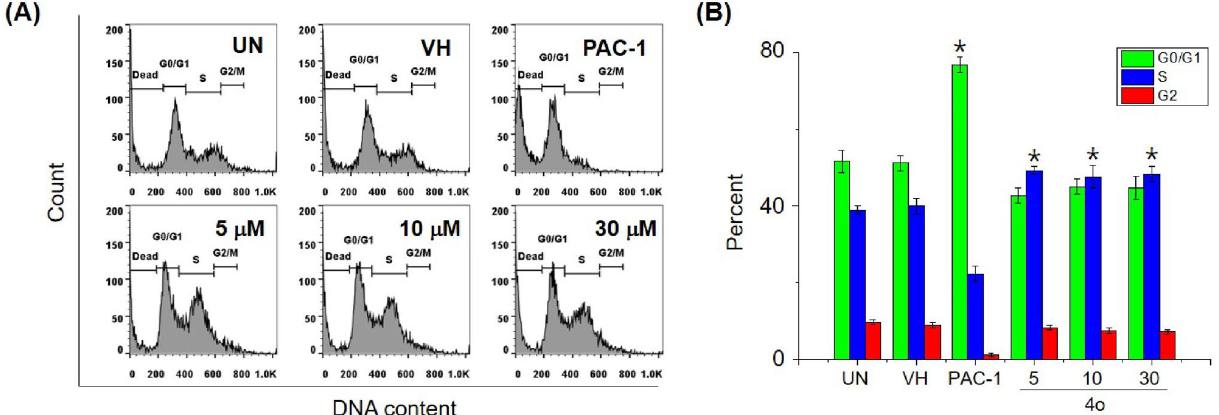
Figure 4. Cell cycle analysis under treatment with different concentrations of compound 4o . U937 human lymphoma cells were treated with compound 4o at 5, 10 and 30 µM or PAC-1 (30 µM) for 24 h. The harvested cells were stained with propidium iodide (PI) in the presence of RNase and then were analyzed for DNA content by using flow cytometry. Ten thousand cells were acquired (n = 3). UN untreated, VH vehicle (DMSO. 0.1%). Representative histograms ( A ) and bar graphs ( B ) are shown. p values were calculated using one-way ANOVA in GraphPad Software (San Diego, CA, USA). * p < 0.01 vs VH